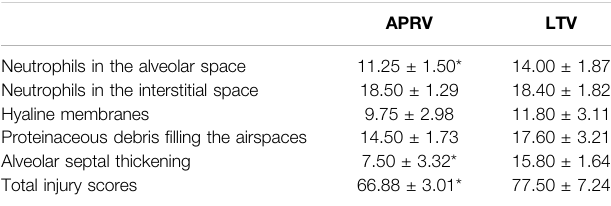
TABLE 1 | Histological injury scores.